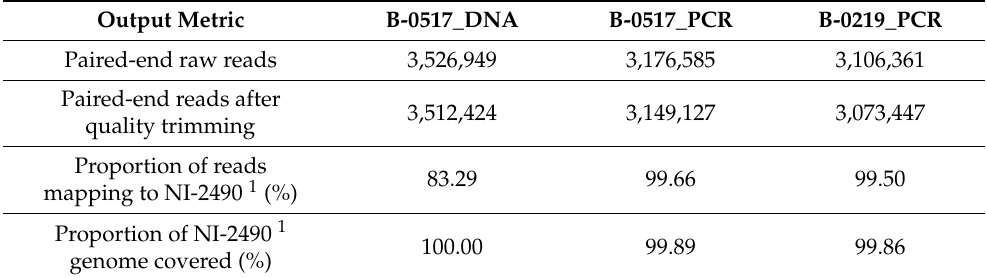
Table 1. Summary of the main output metrics for datasets B-0517_DNA, B-0517_PCR